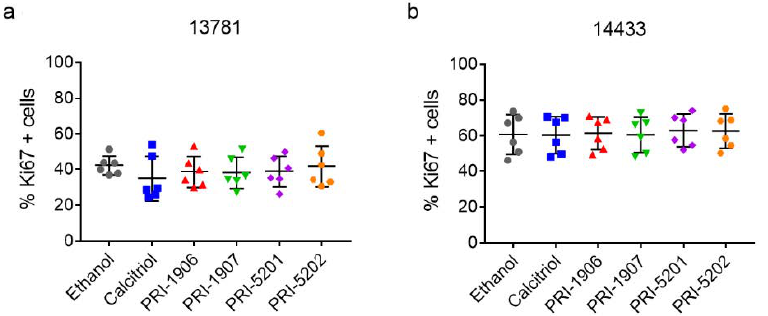
Figure 8. Percentage of KI67 positive cells in ( a ) 13781 and ( b ) 14433 cells after treatment with 100 nmol/L of an1,25Ds for 5 days. RM-ANOVA with Dunnett post-test vs. ethanol control, N = 6.